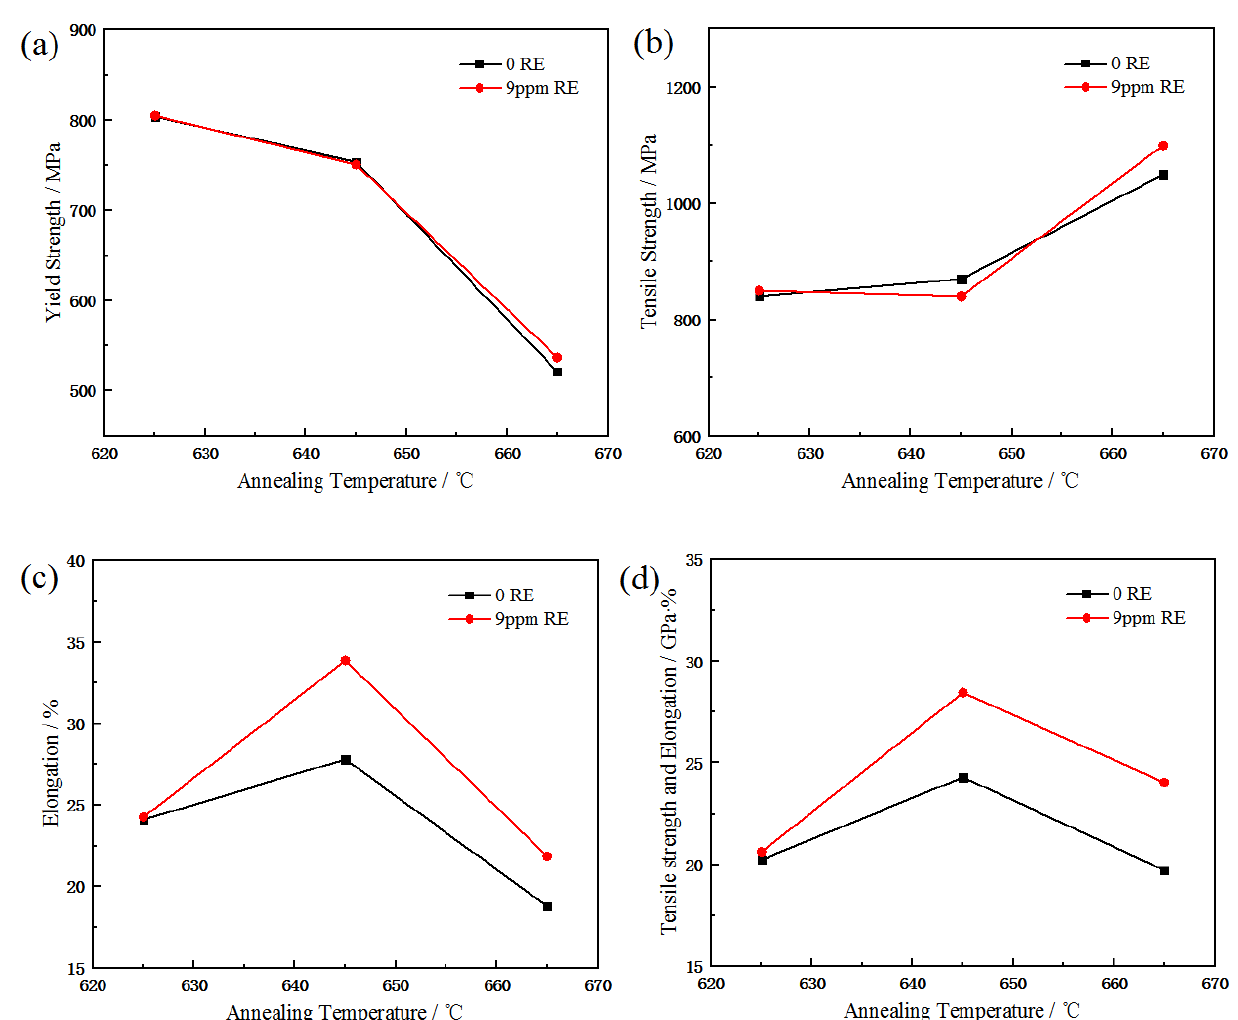
Figure 6. Mechanical properties of two groups of experimental steels at different annealing temperatures: ( a ) yield strength, ( b ) tensile strength, ( c ) elongation, and ( d ) the product of strength and elongation.